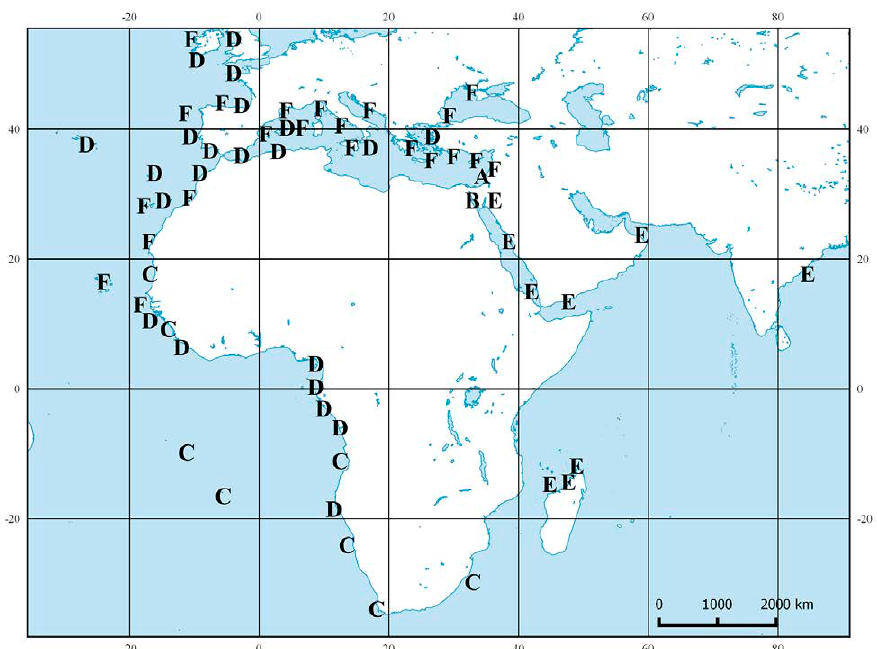
Fig. 3. – Geographical distribution of species of Arnoglossus with several elongate and filamentous rays in anterior dorsal fin, eastern Atlantic, Mediterranean and western Indian Ocean. A, A. nigrofilamentosus n. sp., type locality. B, A. nigrofilamentosus n. sp., presumed original